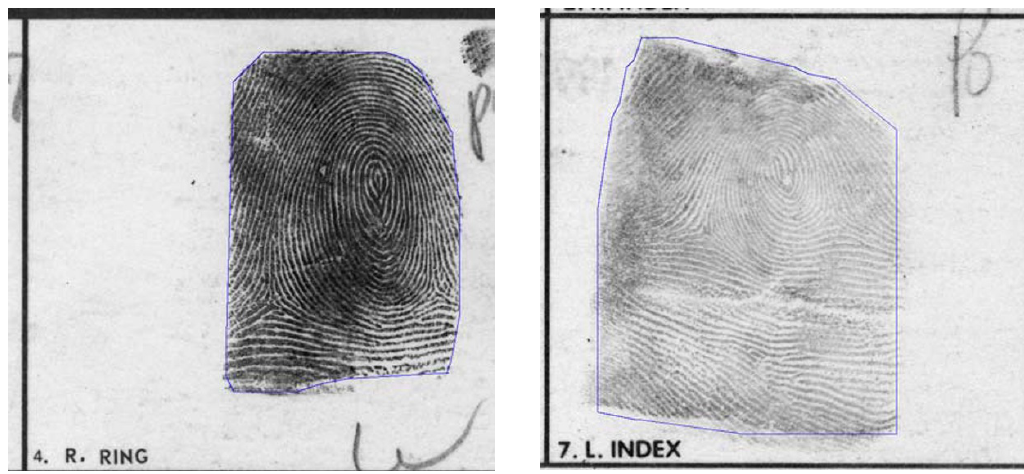
Figure 29: Segmentation results of two fingerprints from NIST 27; the size of image is 800 ×